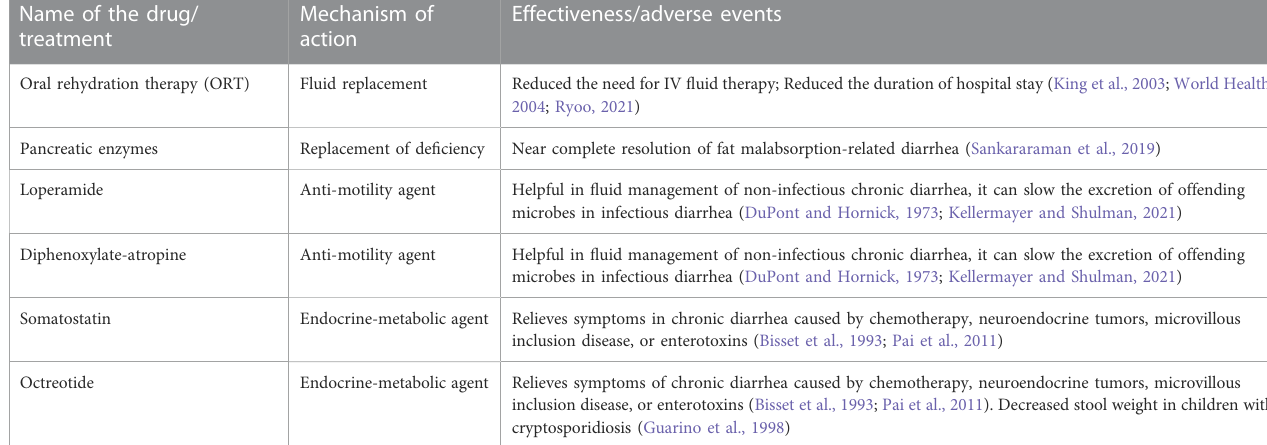
TABLE 1 Conventional treatments for chronic diarrhea in children. Name of the drug/